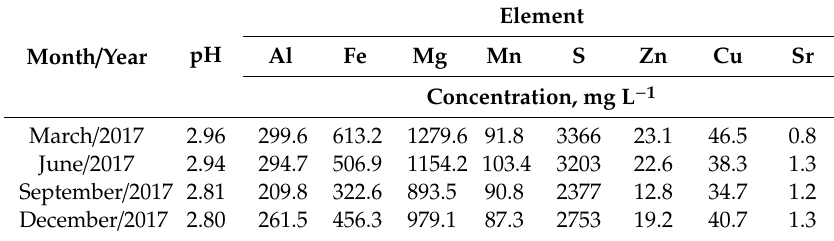
Table 1. Chemical characterization of the Robule Lake from January 2017 to December